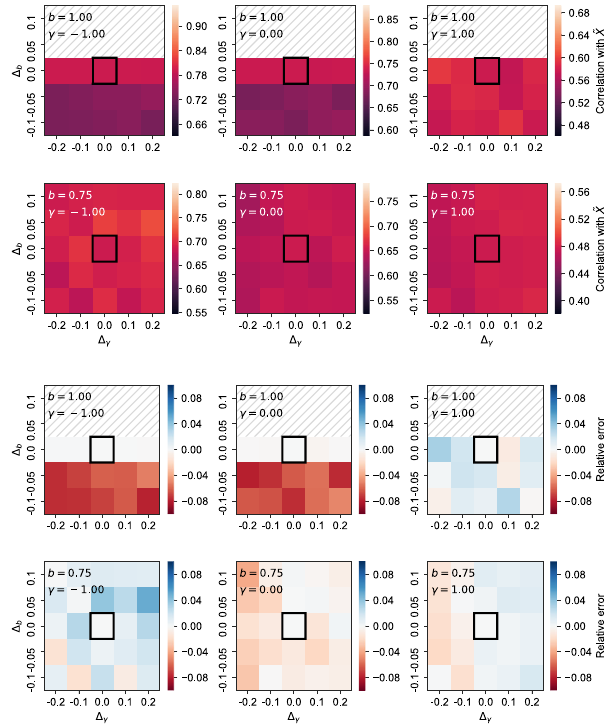
FIG. 10. Sensitivity analysis of the parameter estimators. Average correlation with the ground truth (top six panels) and relative error on the true correlation (bottom six panels) of the histories estimated by running the inference with misspecified parameters. These results are produced on trees ( b ¼ 1 , top rows) and on loopy graph ( b ¼ 0 . 75 , bottom rows), at various levels of heterogeneity ( γ ∈ f − 1 ; 0 þ 1 g from left to right); see also inset text. The bold square shows the reference value (no perturbation), while the rest of the heat map shows results for absolute perturbations of magnitude Δ γ ; Δ b ∈ f − 0 . 2 ; − 0 . 1 ; 0 . 1 ; 0 . 2 g .